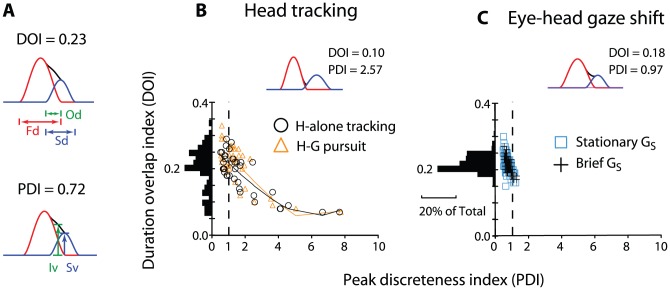
Two examples of the DOI and PDI measures and PDI vs. DOI scattergrams during head tracking movement and eye-head combined gaze shifts.The regression line across the data in B is a least-square function. The movement plotted in Fig. 3A is shown in the inset of B. Od: duration of submovement overlap; Fd: duration of the first submovement; Sd: duration of the second submovement; Iv: intercepted velocity between the first and second submovements: Sv: peak velocity of the second submovement. Data includes only overlapping submovements.